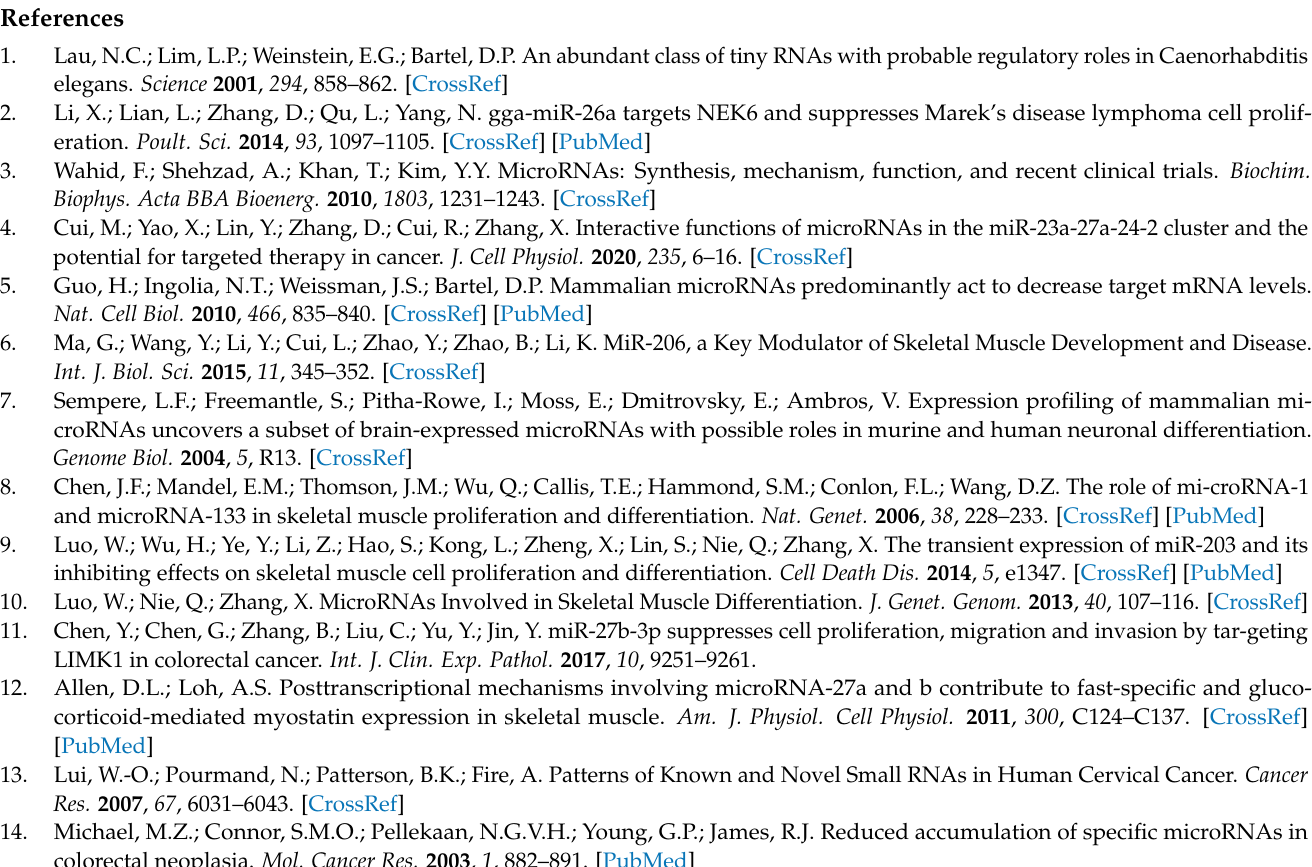
Figure S2: Cell cycle detection after overexpression and interference with MSTN